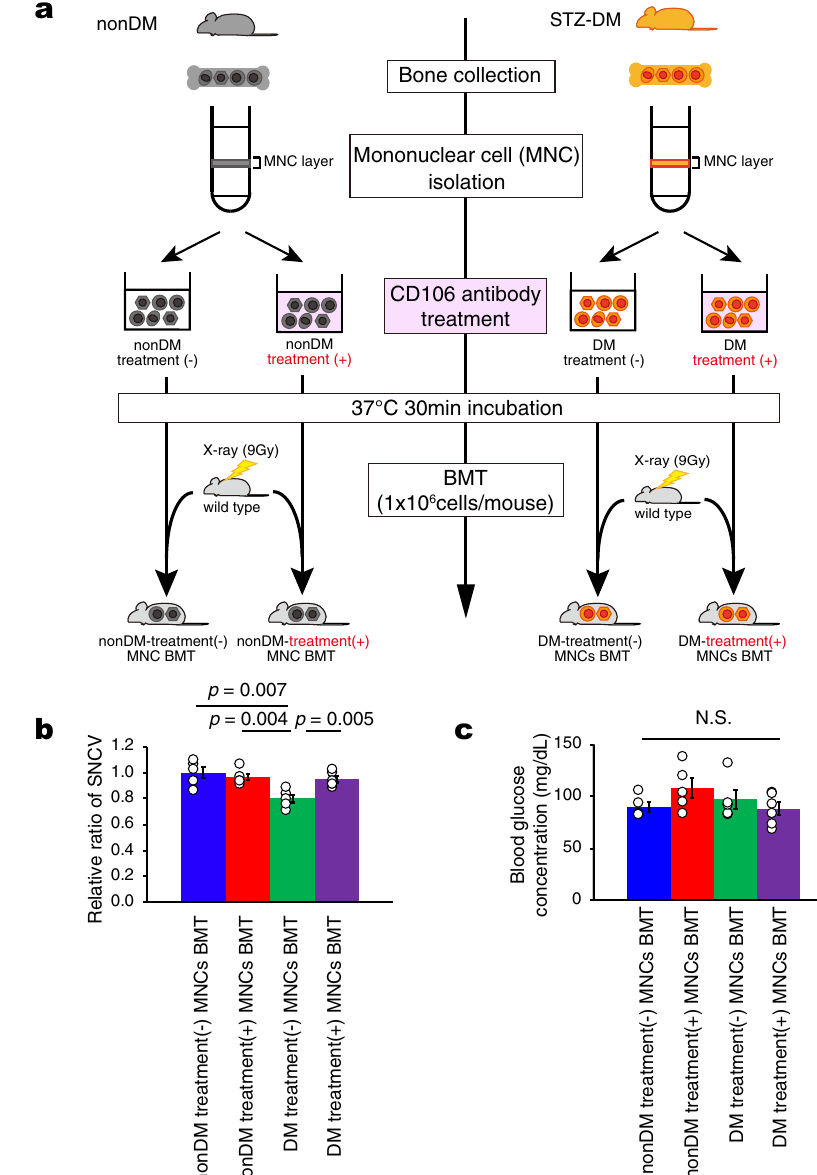
Fig. 7 Treatment of anti-CD106 antibody to diabetic mononuclear cells was improved diabetic neuropathy. We isolated mononuclear cells using fi coll- paque PLUS from nondiabetic and diabetic total bone marrow. The isolated mononuclear cells were incubated anti-CD106 antibody ( fi nal concentration is 10 μ g/ml) for 30 min at 37 degree. Antibody-treated and nontreated cells (1 ×10 6 cells / mouse) were transplanted into 9 Gy lethally-irradiated normoglycemic mice. Four weeks after BMT, we measured blood glucose and sensory nerve conduction velocity. a A schematic experimental method for CD106 antibody treatment ( + ) or ( − ) mononuclear cells transplantation model. b Relative ratio of SNCV of sciatic nerve in nonDM treatment ( − ) MNCs BMT ( n = 5), nonDM treatment ( + ) MNCs BMT ( n = 5), DM treatment ( − ) MNCs BMT ( n = 5) and DM treatment ( + ) MNCs BMT ( n = 6). c Blood glucose concentration of nonDM treatment ( − ) MNCs BMT ( n = 5), nonDM treatment ( + ) MNCs BMT ( n = 5), DM treatment ( − ) MNCs BMT ( n = 5) and DM treatment ( + ) MNCs BMT ( n = 6). N.S means not signi fi cant. Data are indicated as means ± proinsulin- (red) or TNF- α -expressing (red) cells were induced at DRG neurons only in mice receiving episodic glucose injections (Fig. 8d middle and bottom panels). Although MAP2 expression (red) was seen in all neurons of both models, only glucose injection induced positive signals for both MAP2 and GFP (green) in some DRG neurons (Fig. 8d top panels). Furthermore, both proinsulin- (red) and TNF- α (red) were induced in GFP-positive (green) cells of mice receiving episodic glucose injections (Fig. 8d middle and bottom panels). Furthermore GFP-positive signal was expressed inside DRG neuron (Fig. 8e). These results indicate that hyperglycemia due to